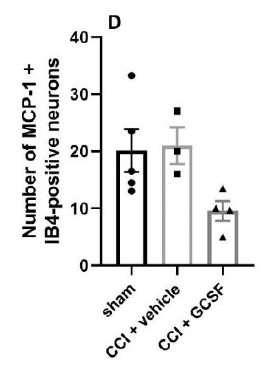
Figure 7. GCSF treatment decreased the number of MCP-1 + CGRP-positive neurons in the DRGs of CCI rats ( B,E ). Immunohistochemical studies revealed that many MCP-1-positive neurons (red) in the DRGs were co-stained with IB4 (green ( A ), a marker of small-diameter, C-fiber nonpeptidergic sensory neurons), CGRP (green ( B ), a marker of small- to medium-diameter peptidergic sensory neurons), and NF200 (green ( C ), a marker of large-diameter myelinated sensory neurons) (Figure 7A– C). Significantly fewer MCP-1 + CGRP-positive neurons were observed in the DRGs of the GCSF- treated CCI rats than in the DRGs of the vehicle-treated CCI rats on the 7th day after nerve injury ( E ). There was a tendency for the GCSF-treated CCI rats to exhibit fewer MCP-1+ IB4-positive neurons in the DRGs than the vehicle-treated CCI rats and sham-operated rats. However, the differences were not statistically significant ( D ). In contrast, there were no significant differences in the number of